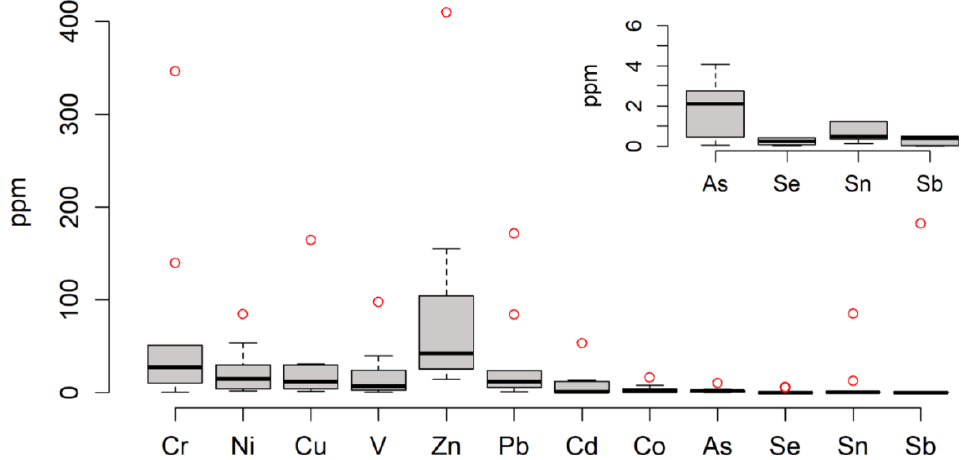
Figure 6. Heavy metal loads extracted from macroplastic particles ( n = 10).